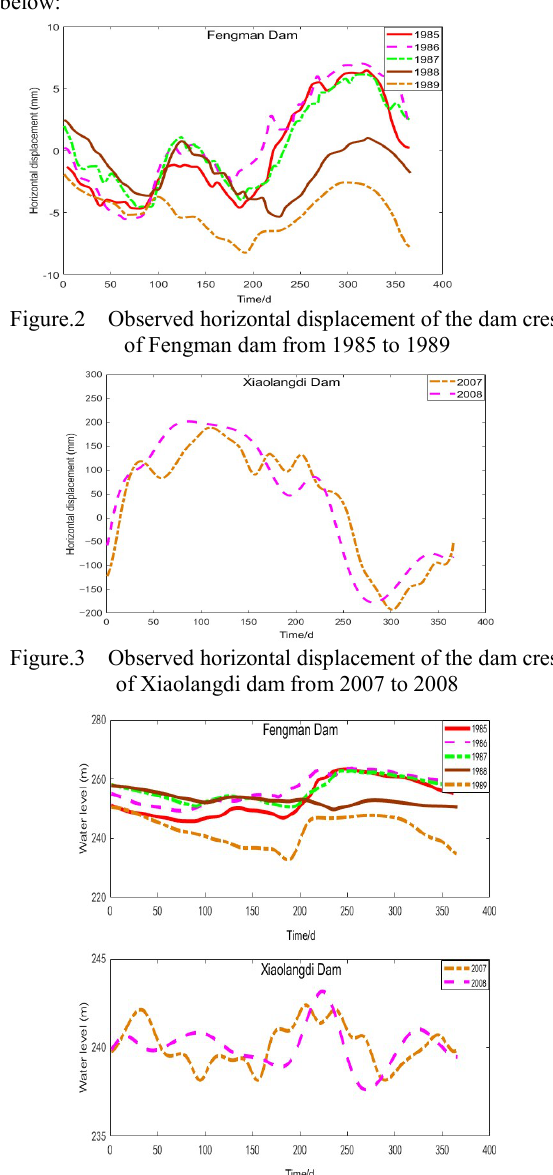
Figure.4 Water level change upstream of the two dams